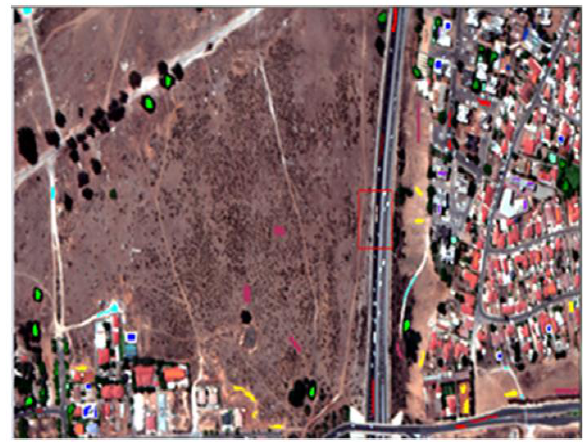
Figure 2. Scene area and ROI used as training samples